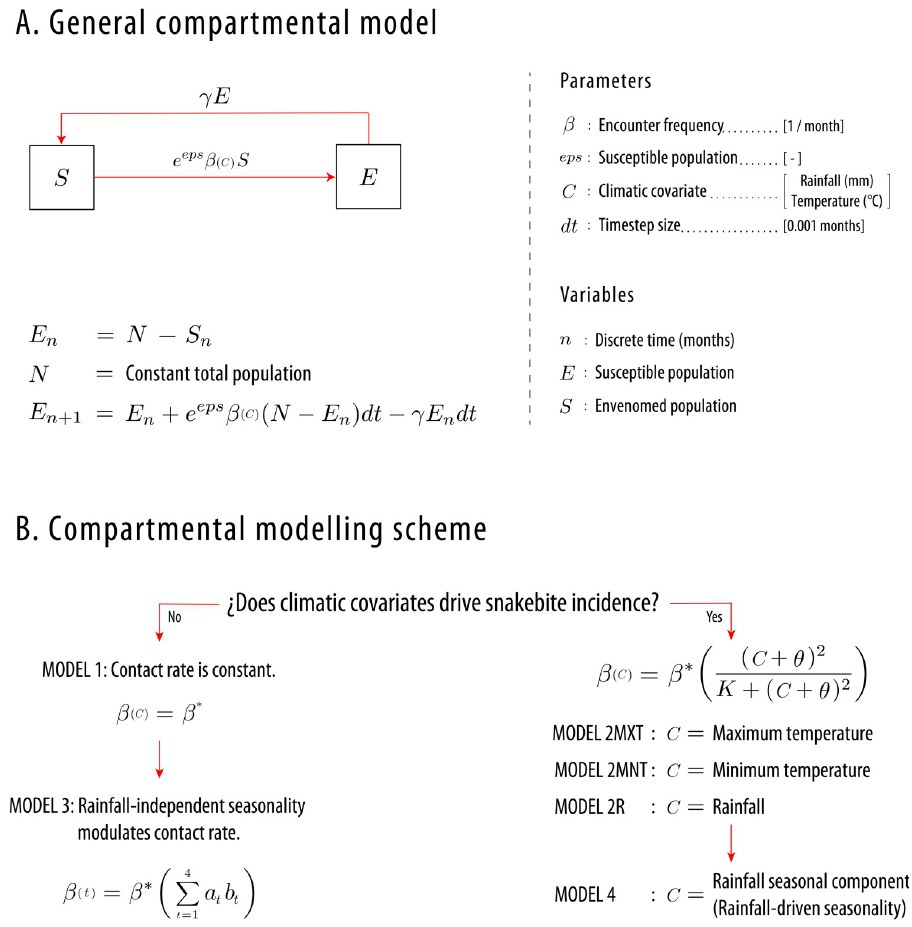
Fig 1. General compartmental model and proposed modeling scheme. A. General compartmental model. Our general model assumes two populations: Susceptible ( S ) and Envenomed ( E ). We defined the flow from S to E as the new envenoming cases per unit of time, which is the incidence. This incidence depends on a gaussian noise ( eps ), the encounter frequency parameter ( β , view [27] for details), and S . By assuming a constant population, we defined a discrete model that only depends on E . B. Compartmental modeling scheme. We defined this scheme to test the effect of climatic covariates on snakebite incidence. First, we tested if the climatic covariate drives snakebite incidence by comparing between a Model where contact rate is constant (Model 1) with a model where this contact rate is modulated by a type III functional response (Model 2). In Model 2, we tested three climatic covariates for national data: Maximum temperature, Minimum temperature and Rainfall. Given that nationally only rainfall modulates snakebite incidence, we did the regional modeling scheme by only using rainfall variables. Then, in regions where Model 1 adjusted better data than Model 2 (Areas where incidence is not modulated by climatic covariates), we tested with Model 3 for rainfall-independent seasonality in incidence timeseries. Finally, in regions where Model 2R (Model 2 with rainfall as covariate) adjusted better data, we tested if the seasonal component of this rainfall (Rainfall-driven seasonality) is the driver behind this association by using Model 4.